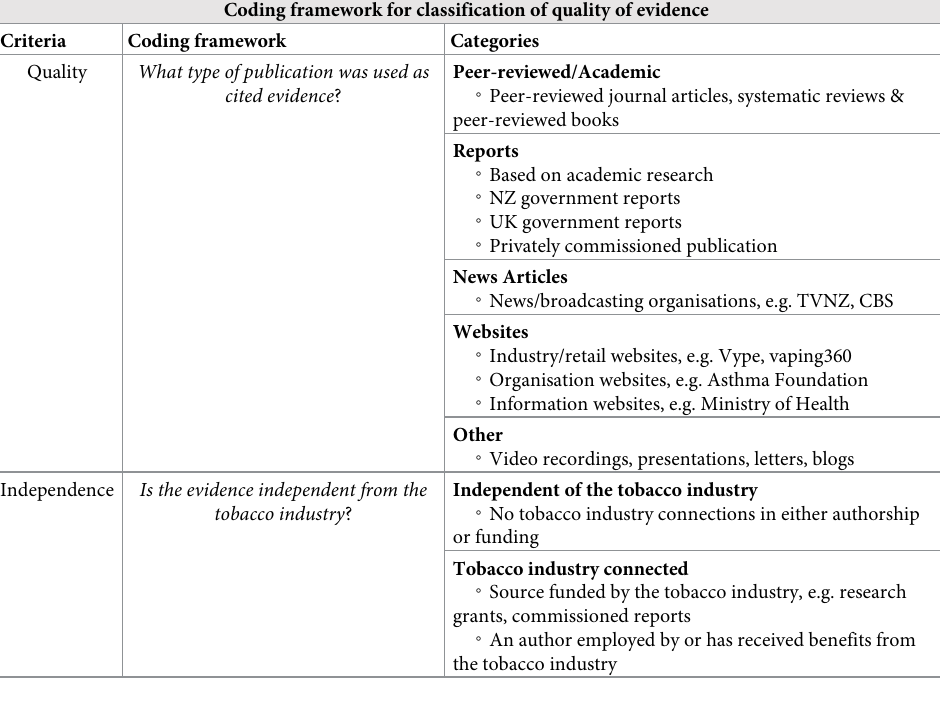
Table adapted from Hatchard et al.